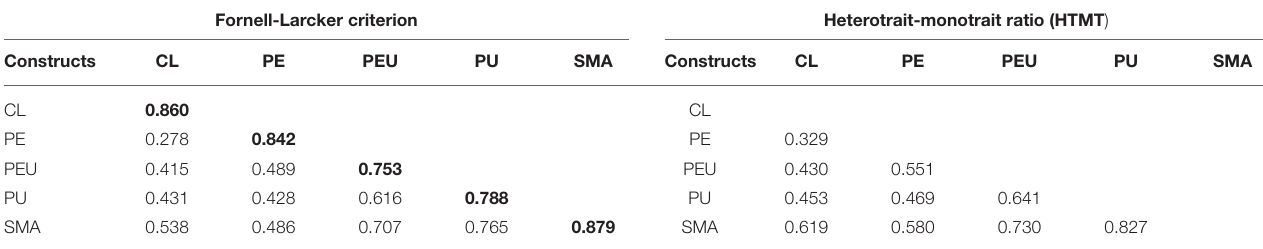
TABLE 3 | Discriminant validity.